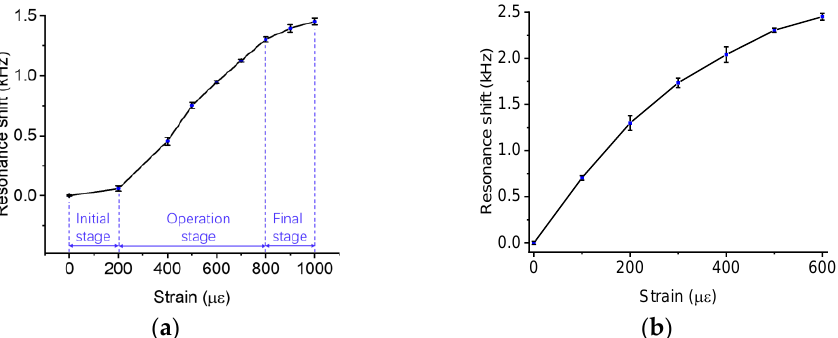
Figure 6. The calibration curves of two BAW sensors with different preloads. Each experiment is repeated five times. ( a ) The calibration curve of a sensor with a lower preload. ( b ) The calibration curve of a sensor with a higher preload. The average sensitivities of Sensor A and B are 1.4 Hz/με and 4.1 Hz/με, respectively. The maximum resonant frequency shifts are 1452 Hz and 2451 Hz, respectively. The maximum strain that these two sensors can measure is approximately 1000 με and 600 με.